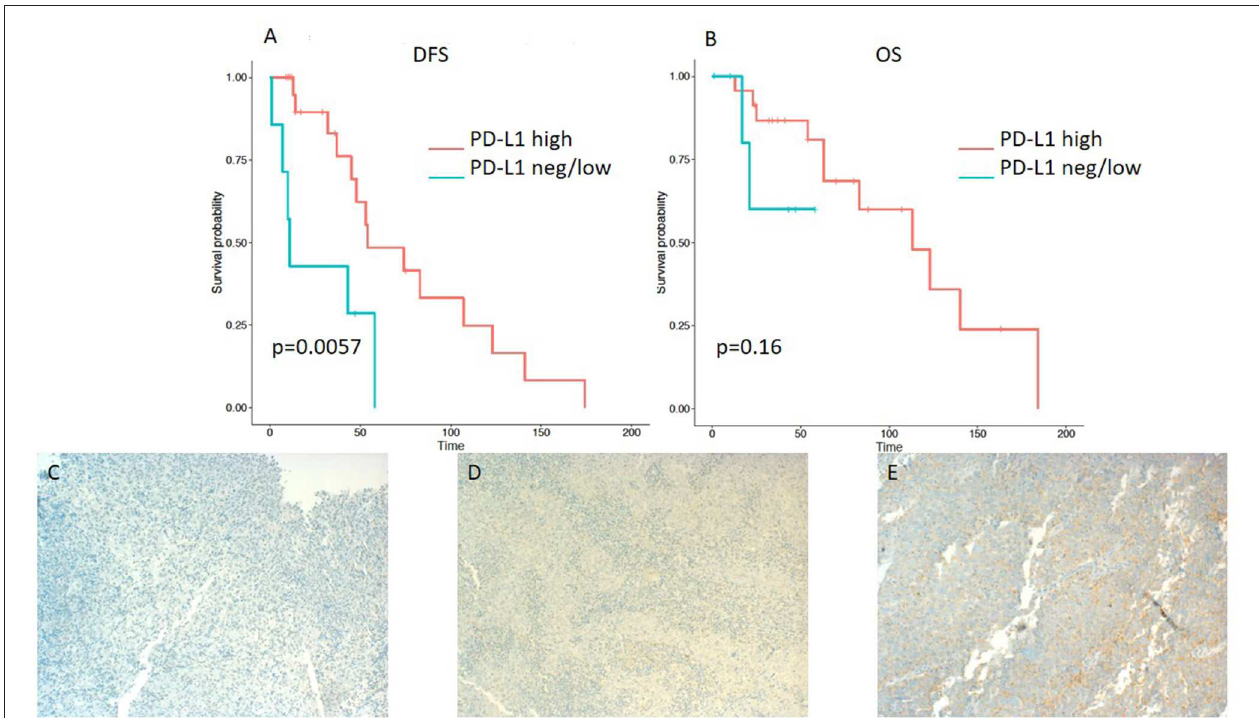
FIGURE 2 | Kaplan–Meier curves for DFS (A) and OS (B) according to PD-L1 expression on tumor infiltrating lymphocytes (TILs) (neg/low vs. high). Representative images of PD-L1 expression on TILs: (C) negative, (D) low, and (E) high (x100 magnification). Log-rank tests were performed, and p -values are depicted.